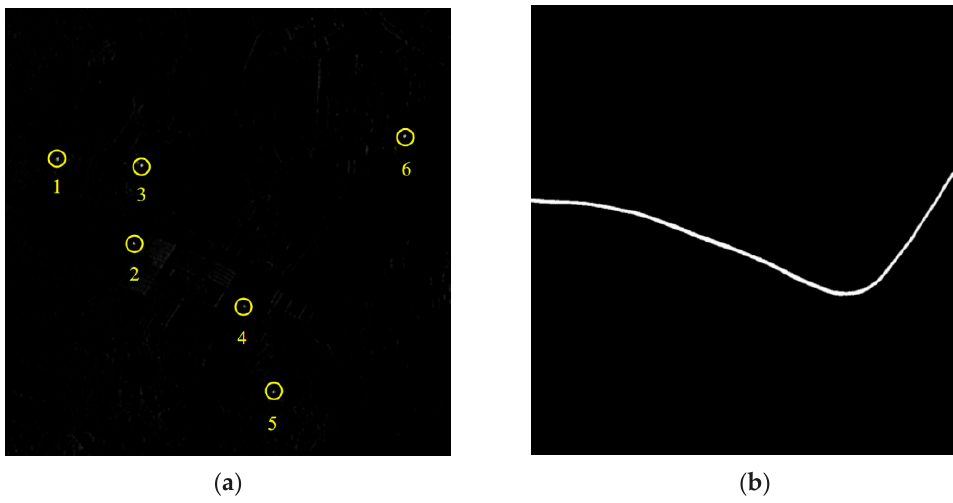
Figure 6. ( a ) The target detection via watershed algorithm; ( b ) The extracted road in the SAR image.